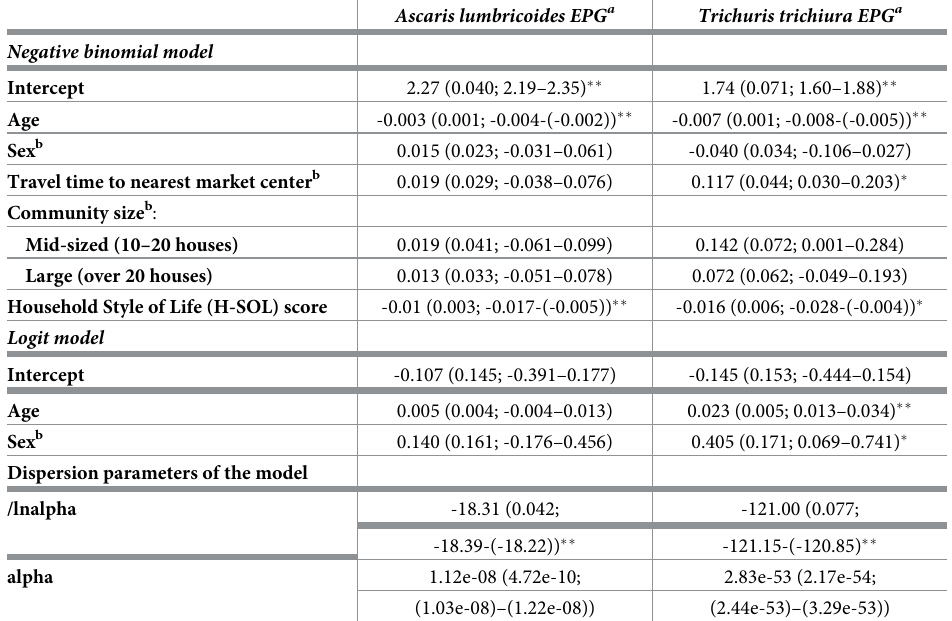
Table 4. Associations between Household Style of Life (H-SOL) scores and helminth infection intensity